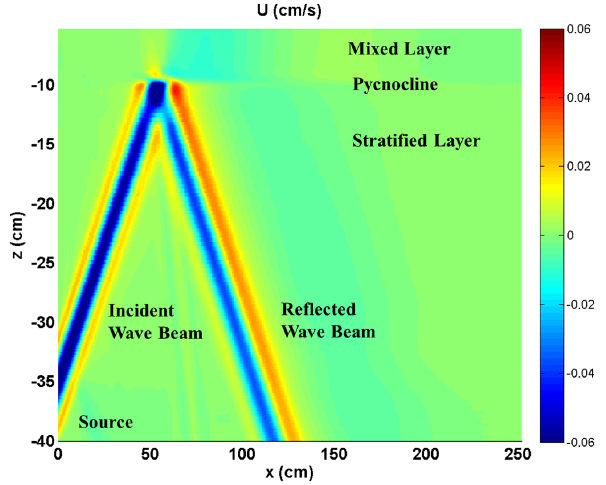
Figure 2. Example image of the horizontal velocity u(x,z) from the simulation with θ = 25 ◦ and r =